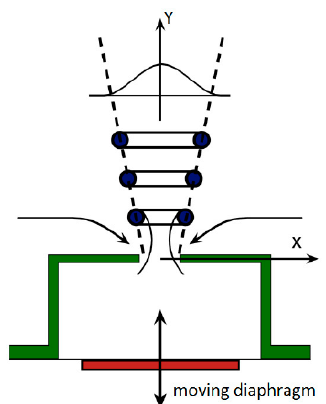
Figure 1. Schematic of a pulsatile jet [51].